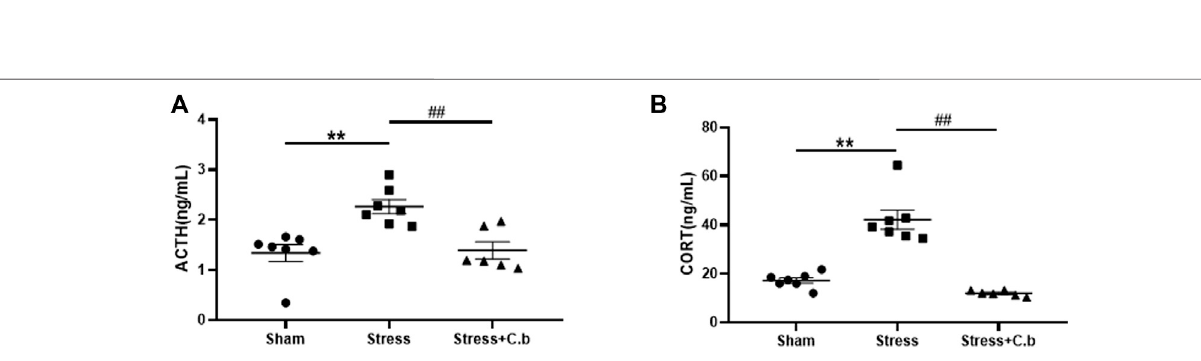
FIGURE 4 | C. butyricum RH2 treatment reversed CFSS-induced decrease in weight gain but not the decrease in food intake. (A) The weight gain (B) The food intake. ** p < 0.01 versus sham group; # p < 0.05, ## p < 0.01 versus stress group; ^^ p < 0.01 versus stress + C. butyricum group.